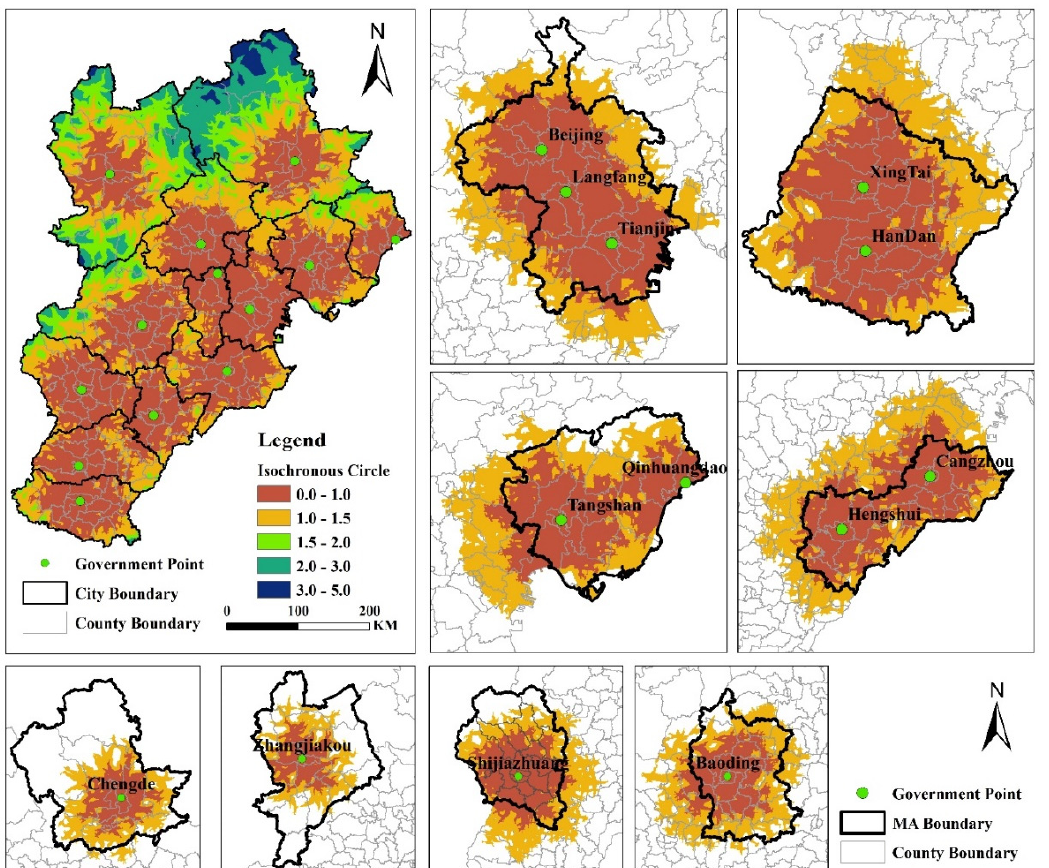
Figure 11. Spatial pattern of transportation accessibility in the BTH region.